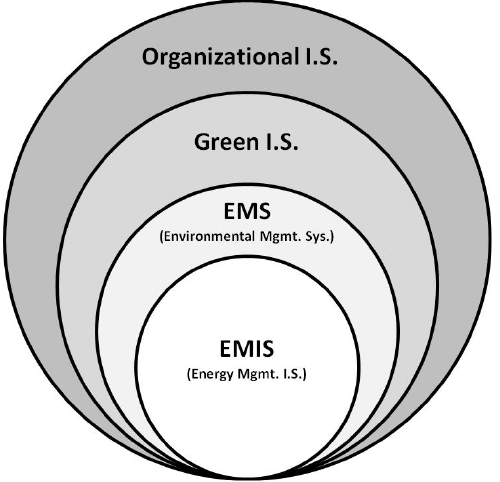
Figure 5. Energy management IS in relation to other IS systems.